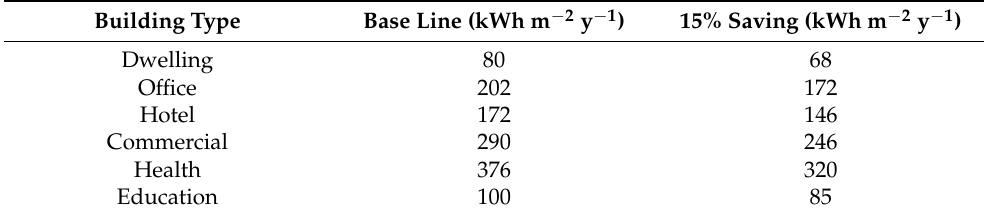
Table 4. Energy consumption rate for buildings in Panama [65].